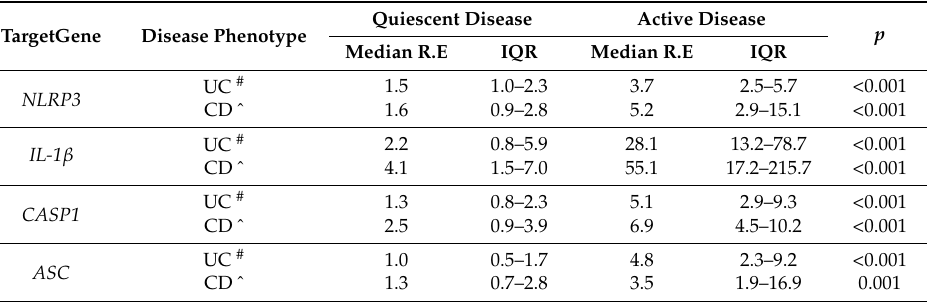
Table 3. Relative expression of NLRP3 related genes in IBD.